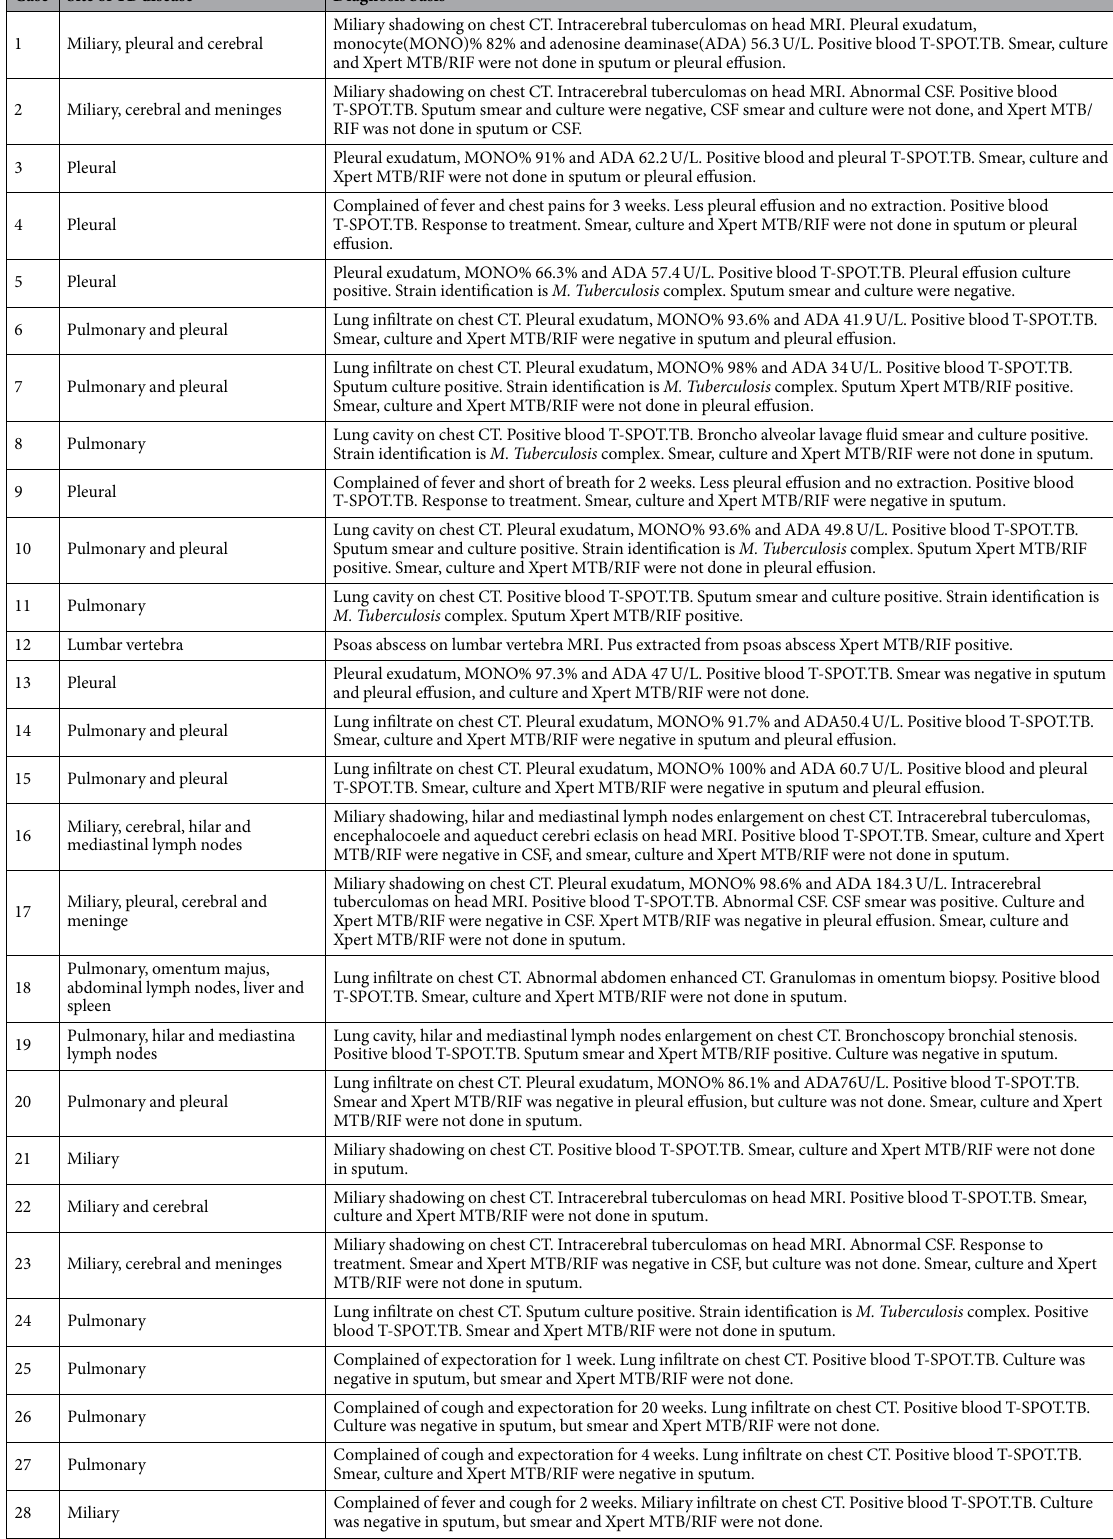
Table 2. Site of TB disease and diagnosis basis of 28 TB patients during